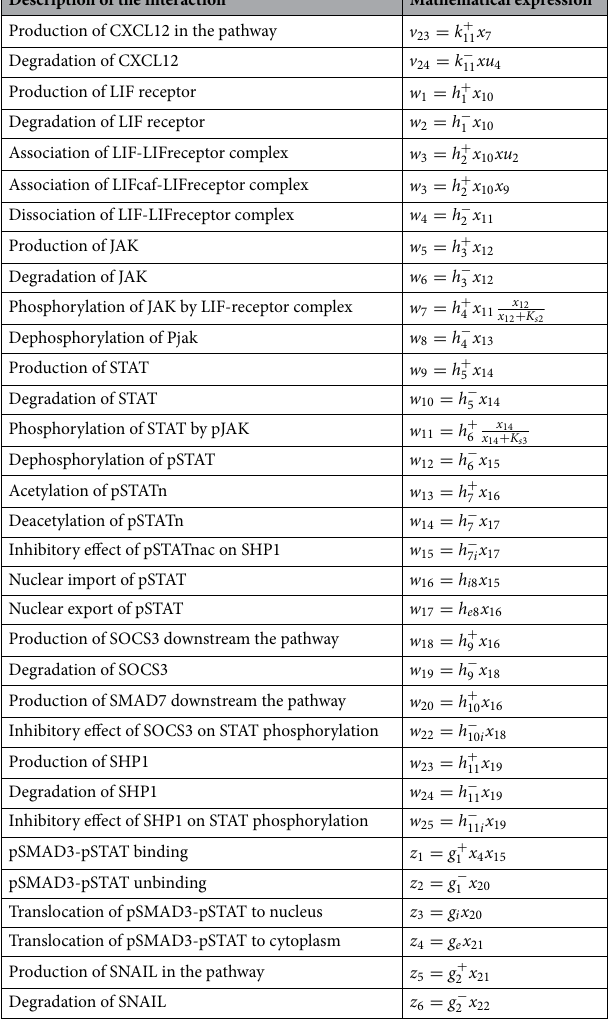
Table 2. Biochemical reactions and their mathematical representations in CAF